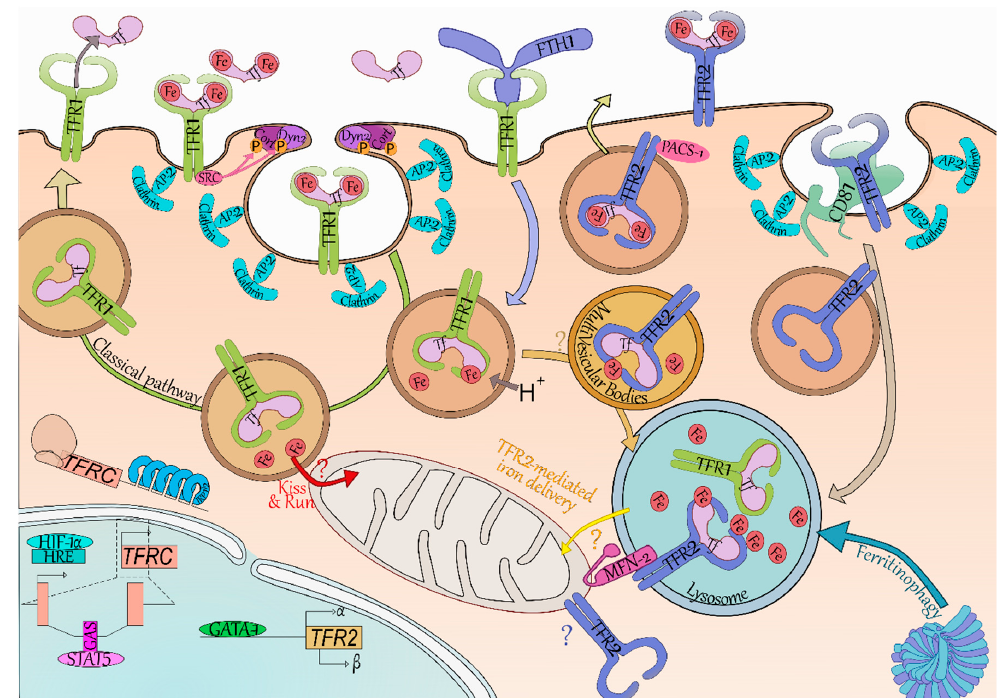
Figure 1. An erythroid-specific iron delivery pathway to mitochondria.